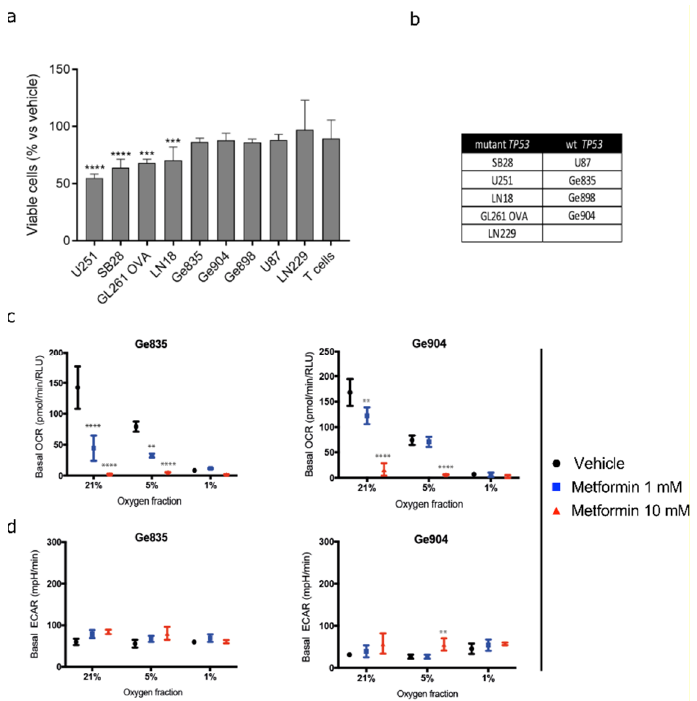
Figure 4. Functional assays of human and mouse GBM cell lines exposed to metformin. ( a ) Effect of 10 mM metformin on viable cell number under physioxia; ( b ) Table indicating TP53 mutation status of all GBM cell lines used; mutant or wild type (WT); ( c ) Basal oxygen consumption rate (OCR) and ( d ) basal extracellular acidification rate (ECAR) of Ge835 and Ge904 GBM cell lines in vitro at 21%, 5%, and 1% O 2 , with the indicated concentrations of metformin (mean of 3 independent experiments +/- SD; 2-way ANOVA, Sidak’s adjusted p -value. ** p < 0.01, *** p < 0.001, **** p < 0.0001) .